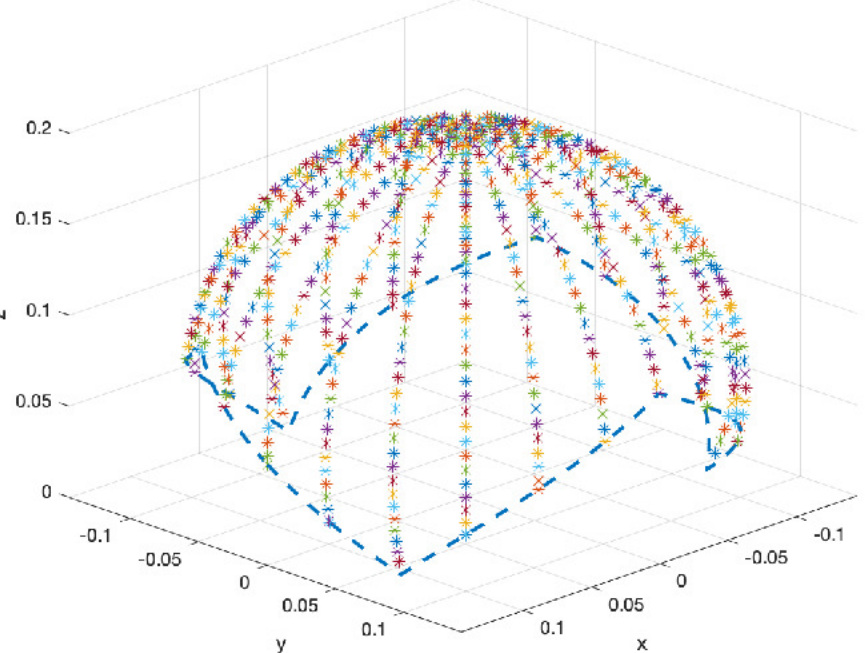
Figure 14. Perspective view of the soft link end positions represented by ‘ ∗ ’ marks, at different orientation planes, every 15 degrees, and for every 5 inclination degrees. The dashed line indicates the flexion limits of the soft joint for each orientation. The soft joint cannot reach further positions due to